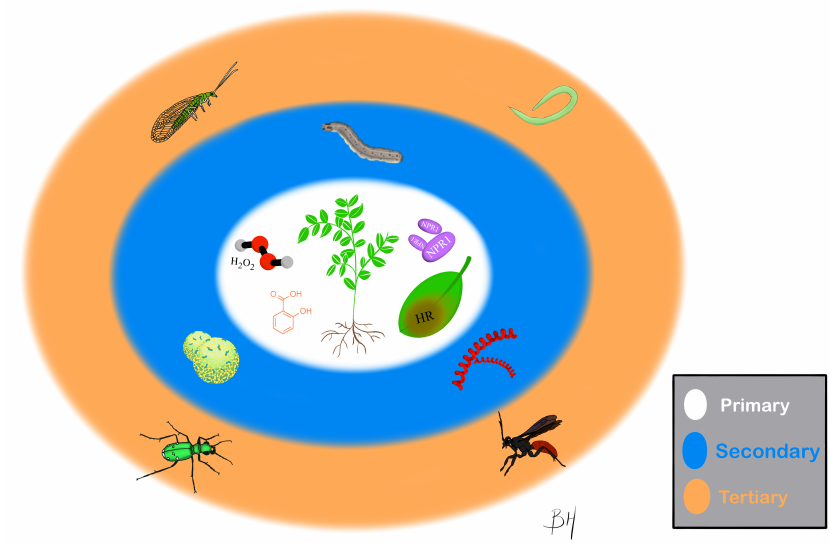
Figure 1. Primary, Secondary and Tertiary Effects of SA Signaling. Primary effects encompass plant specific effects. Secondary effects involve direct and indirect interactions with pathogens and herbivores. Tertiary effects comprise interactions with natural